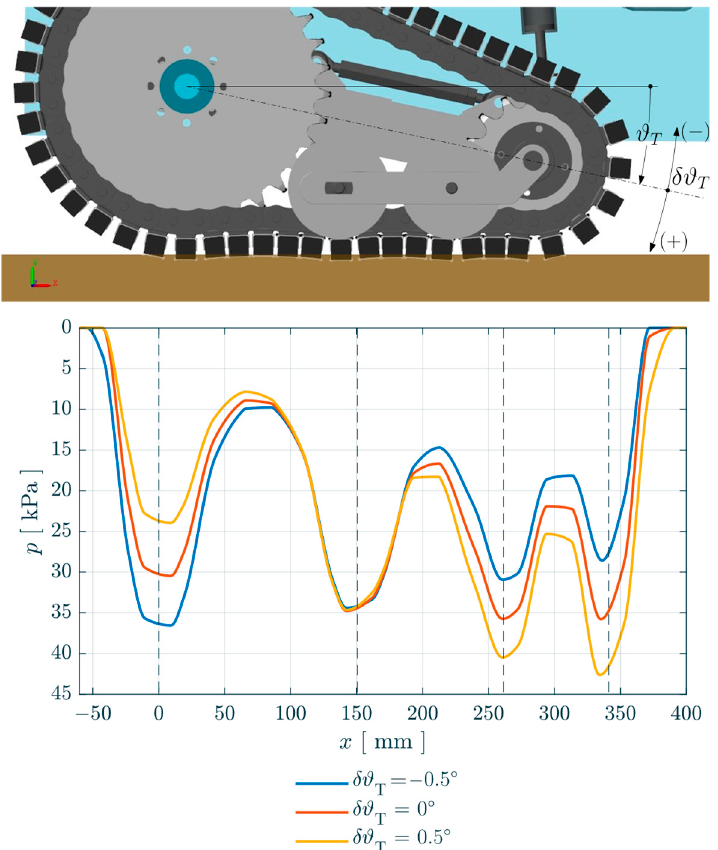
Figure 21. Normal pressure distribution under the reconfigurable module in track mode: effect of control target deviation ( δϑ T ).